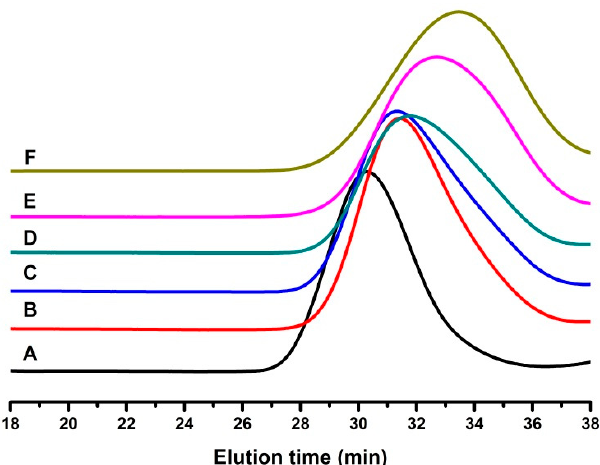
Figure 2. Gel-permeation chromatography (GPC) traces of poly(IB- co -4-VBCB) initiated by the TMPCl/DTBP/TiCl 4 system in cyclohexane/CH 3 Cl (60/40 v/v ) at − 80 °C, [IB] = 1.01 M, [TMPCl] = 1.41 × 10 − 3 M, [DTBP] = 3.53 × 10 − 3 M, and [TiCl 4 ] = 4.52 × 10 − 2 M (A, B, C, D, E, and F correspond to the terms in Table 1).